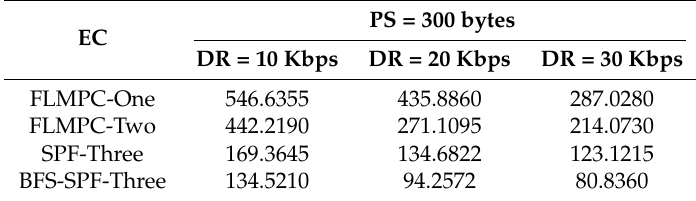
Table 7. EC Values with PS of 300